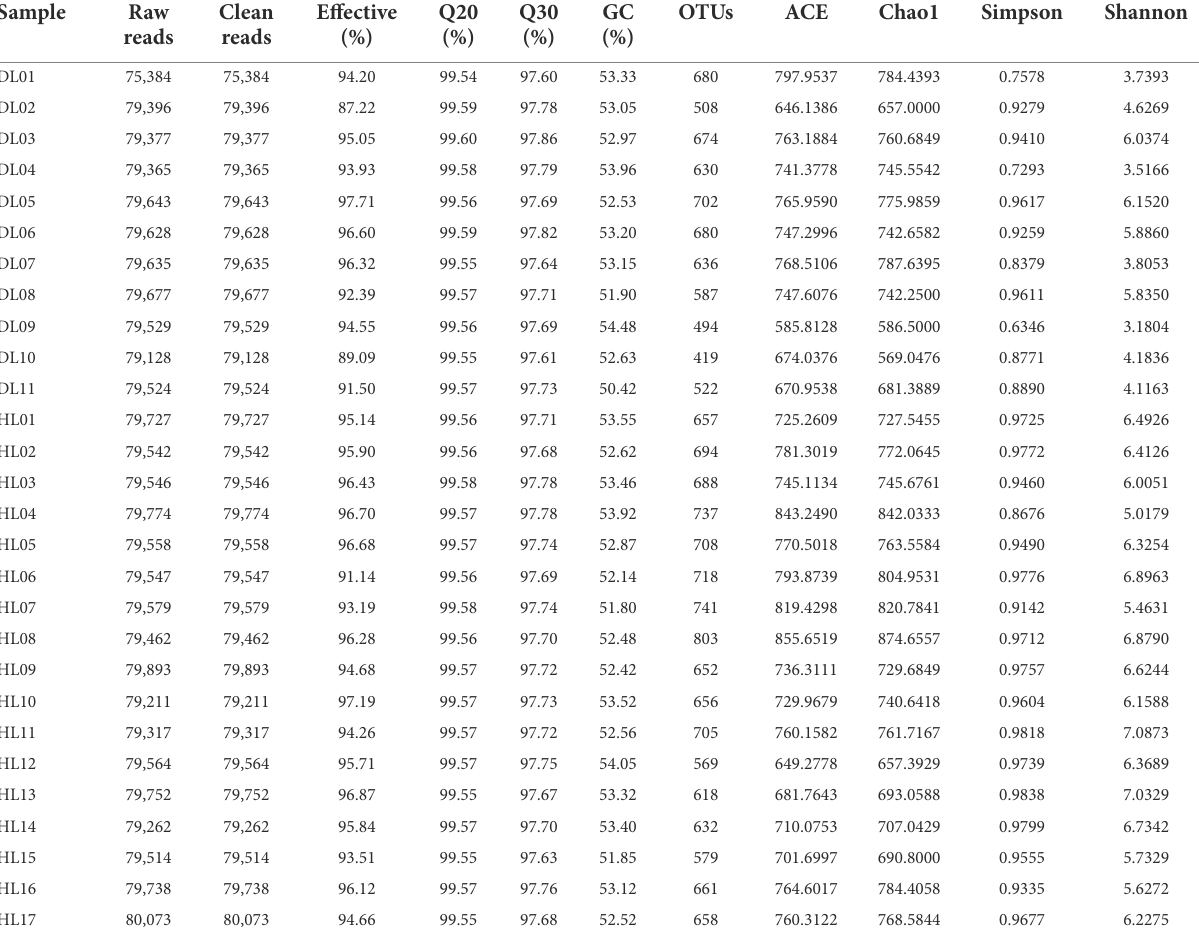
TABLE 1 OTU-based diversity indexes of gut microbiota in diarrheic and healthy lambs.